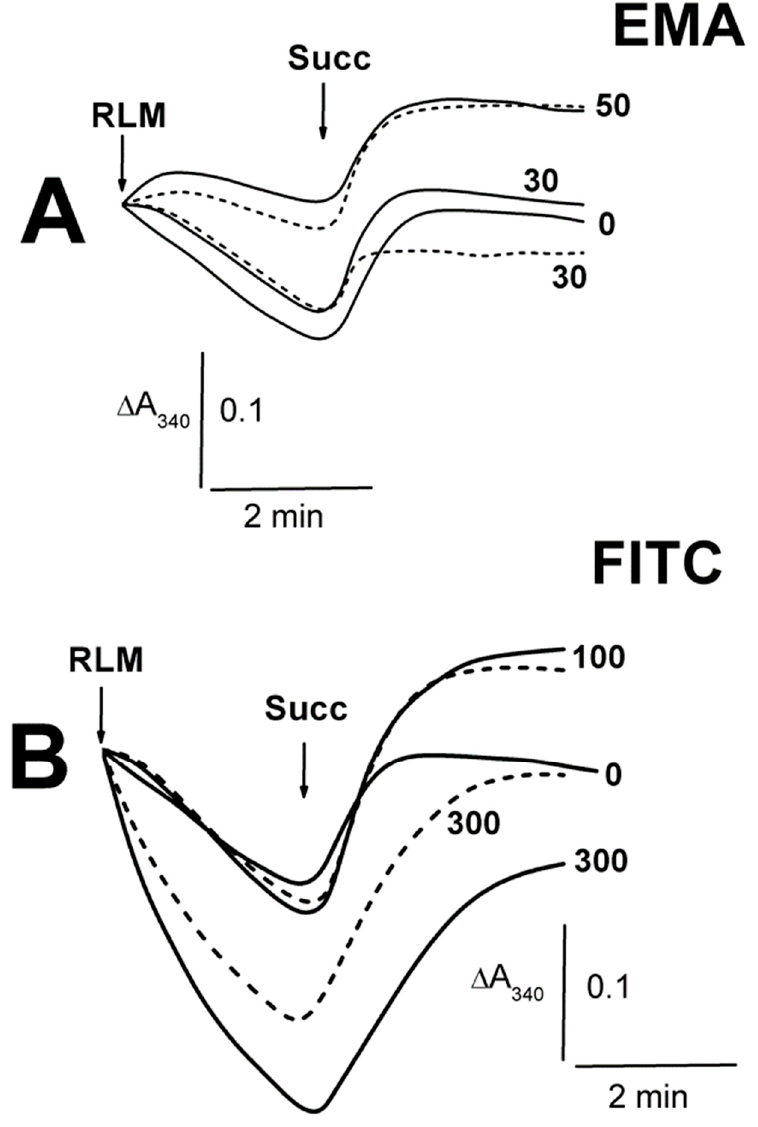
Figure 2. The influence of EMA and FITC on the Tl + -induced swelling of rat liver mitochondria. Mitochondria (1.5 mg/mL of protein) were placed into the medium A containing 75 mM TlNO 3 . The numbers on the right of the traces show concentrations ( µ M) of EMA ( A ) or FITC ( B ), injected into the medium before mitochondria. Additions of mitochondria (RLM) and 5 mM succinate (Succ) are shown by arrows. The medium was additionally supplemented by 500 µ M ADP (short dash traces).